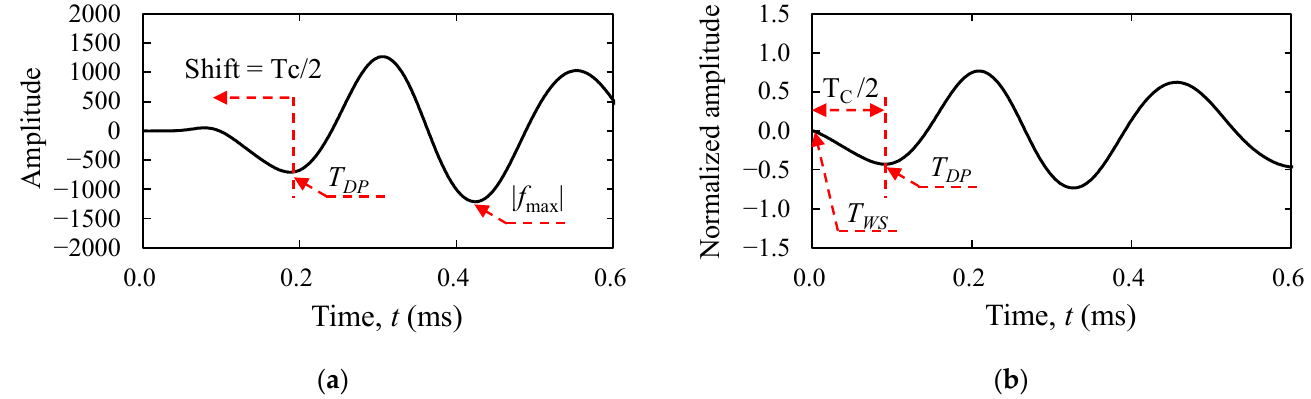
Figure 8. Example of waveform normalization: ( a ) Before normalization; ( b ) After normalization.